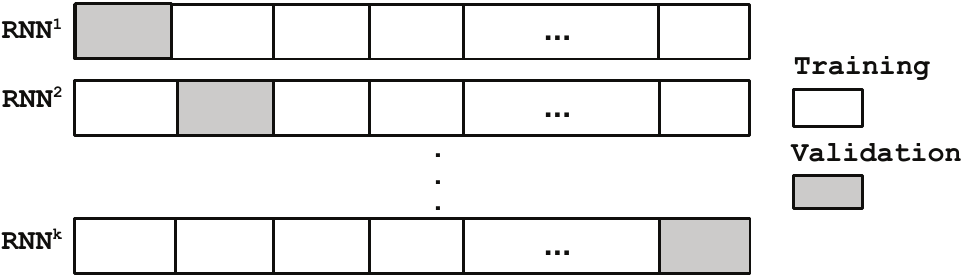
Figure 2. An ensemble of k RNN models based on a k -fold cross